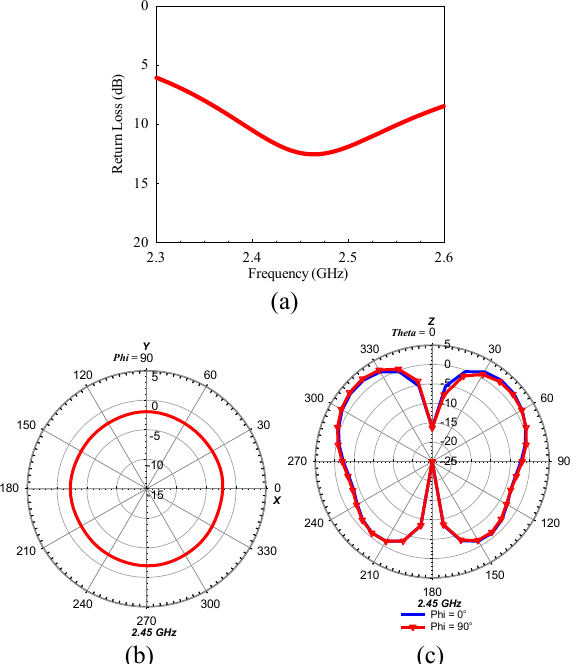
Figure 6: (a) S-parameters of the proposed RFSR, (b) horizontal-cut antenna pattern, and (c) vertical-cut antenna pattern.